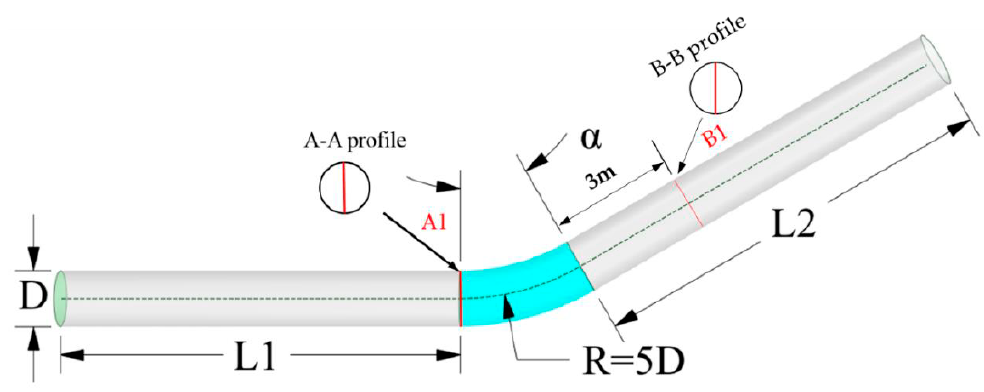
Figure 1. Geometrical model of the pipeline. Table 1. Parameters of the geometrical model.